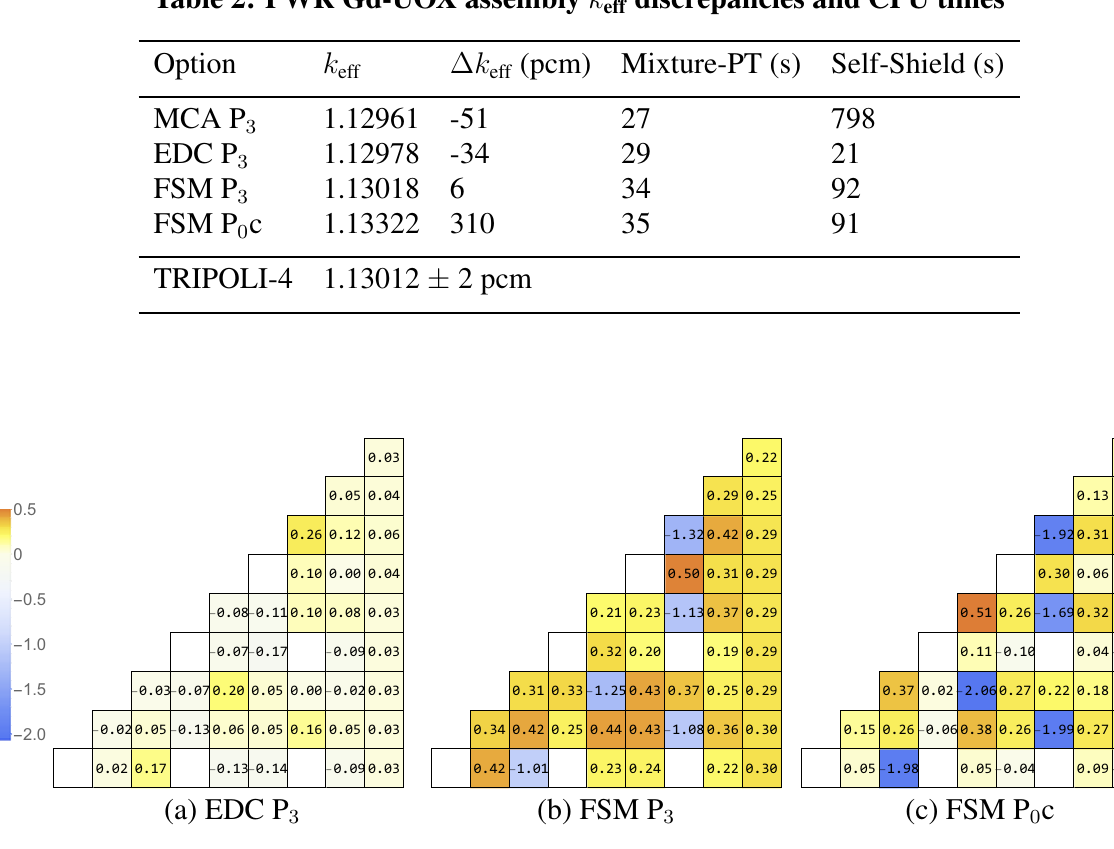
Table 2: PWR Gd-UOX assembly k